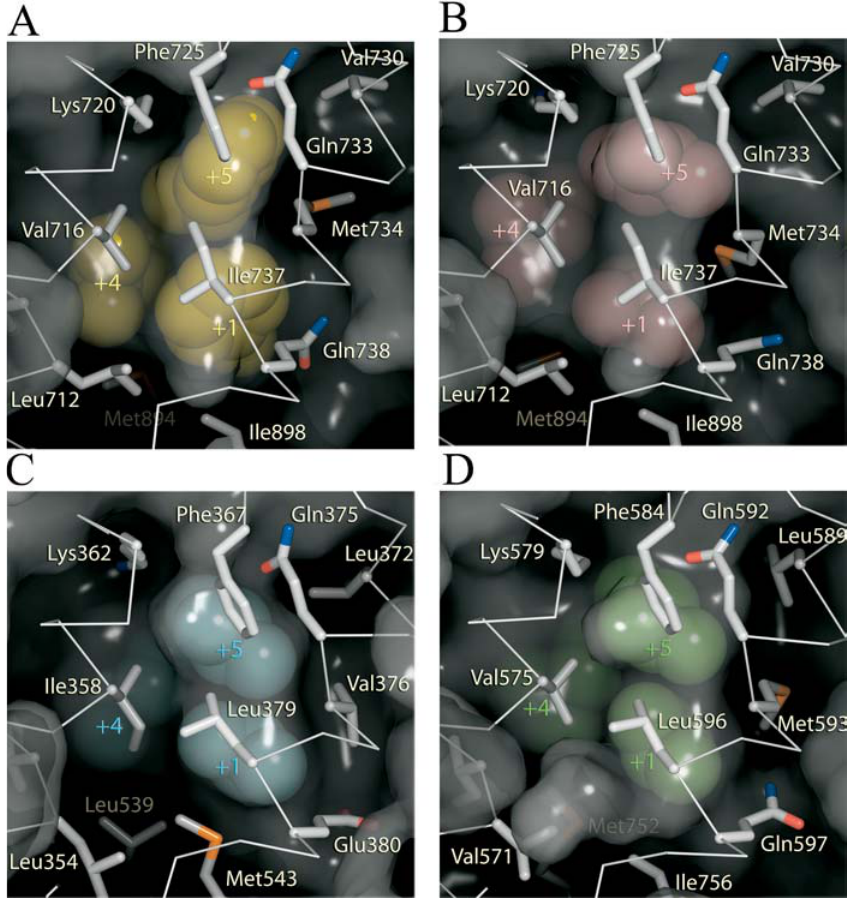
Figure 9. Surface Complimentarity of Hydrophobic Motifs in the AR, ER a , and GR AF-2 Clefts (A) AR–FxxLF, (B)AR–LxxLL, (C) ER a – GRIP1 (LxxLL) (Shiau et al. 1998), and (D) GR-TIF2 (LxxLL) (Bledsoe et al. 2002). The inside surfaces of the